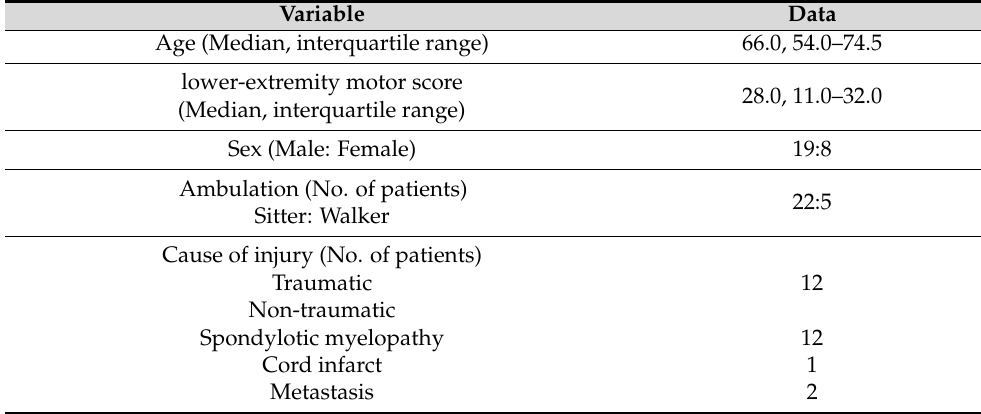
Table 1. Demographic